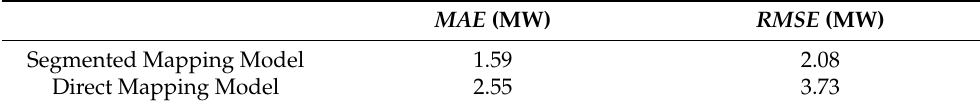
Table 3. Error comparison of grid connection power calculation